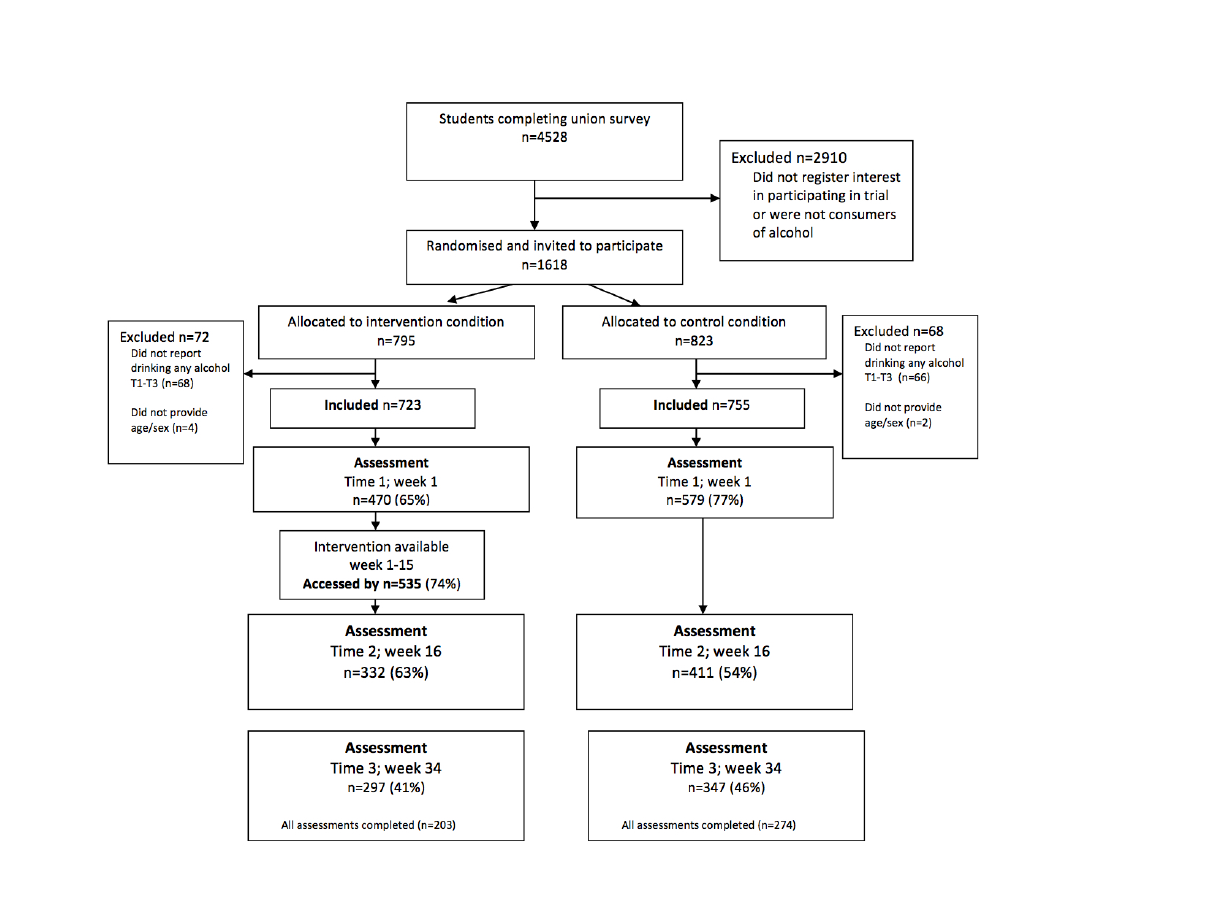
Figure 1. Participant flow through the